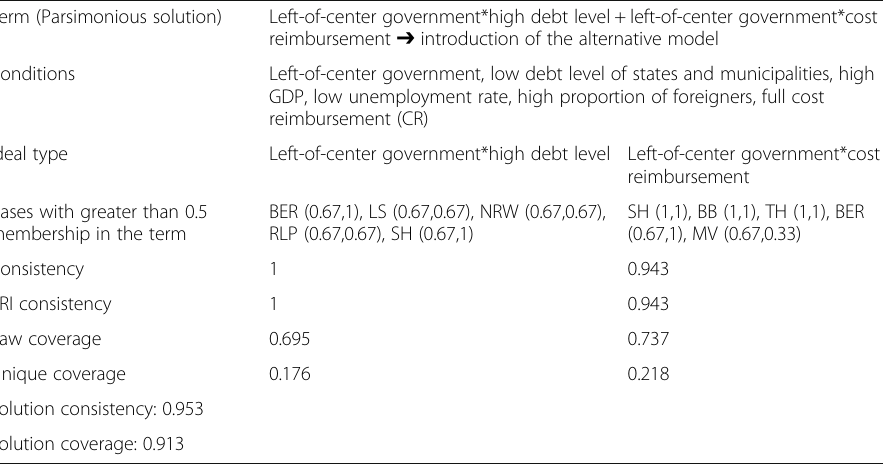
Table 2 Test for sufficient conditions for the “ Introduction of the alternative model ” outcome Term (Parsimonious